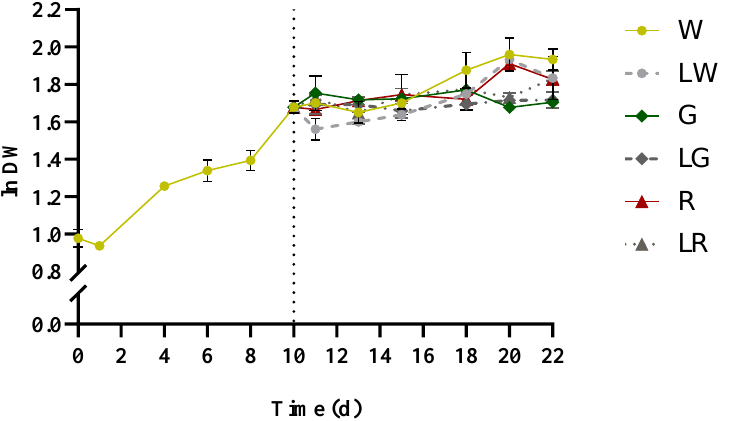
Figure 3. Growth curves of S. salina LEGE 06155, expressed as logarithm of dry weight (ln DW) versus time (per day). The vertical dotted line denotes the separation between phase I: treatment of W (white, 150 µ mol photons · m − 2 · s − 1 ) (control), from 0 to 10th days (left) and phase II: LW (low white, 50 µ mol photons · m − 2 · s − 1 ), G (green, 150 µ mol photons · m − 2 · s − 1 ), LW (low green, 50 µ mol photons · m − 2 · s − 1 ), R (red, 150 µ mol photons · m − 2 · s − 1 ), and LR (low red, 50 µ mol photons · m − 2 · s − 1 ) from 10th to 22nd days (right). The data points show average ± SD, n =3. Table 1. Kinetic parameters determined for growth of phase II of S. salina LEGE 06155 cultivation: µ average (average specific growth rate) , expressed in d −1 , and P x (average productivity), expressed in g·L − 1 ·d − 1 for each applied light treatment: W (white, 150 μmol photons ·m −2 ·s −1 ) (control), LW (low white, 50 μmol photons ·m −2 ·s − 1 ), G (green, 150 μmol photons ·m − 2 ·s − 1 ), LW (low green, 50 μmol photons ·m −2 ·s −1 ), R (red, 150 μmol photons ·m −2 ·s −1 ), and LR (low red, 50 μmol photons ·m −2 ·s −1 ). The lowercase letters denote statisti- cally significant differences across columns ( p < 0.05).